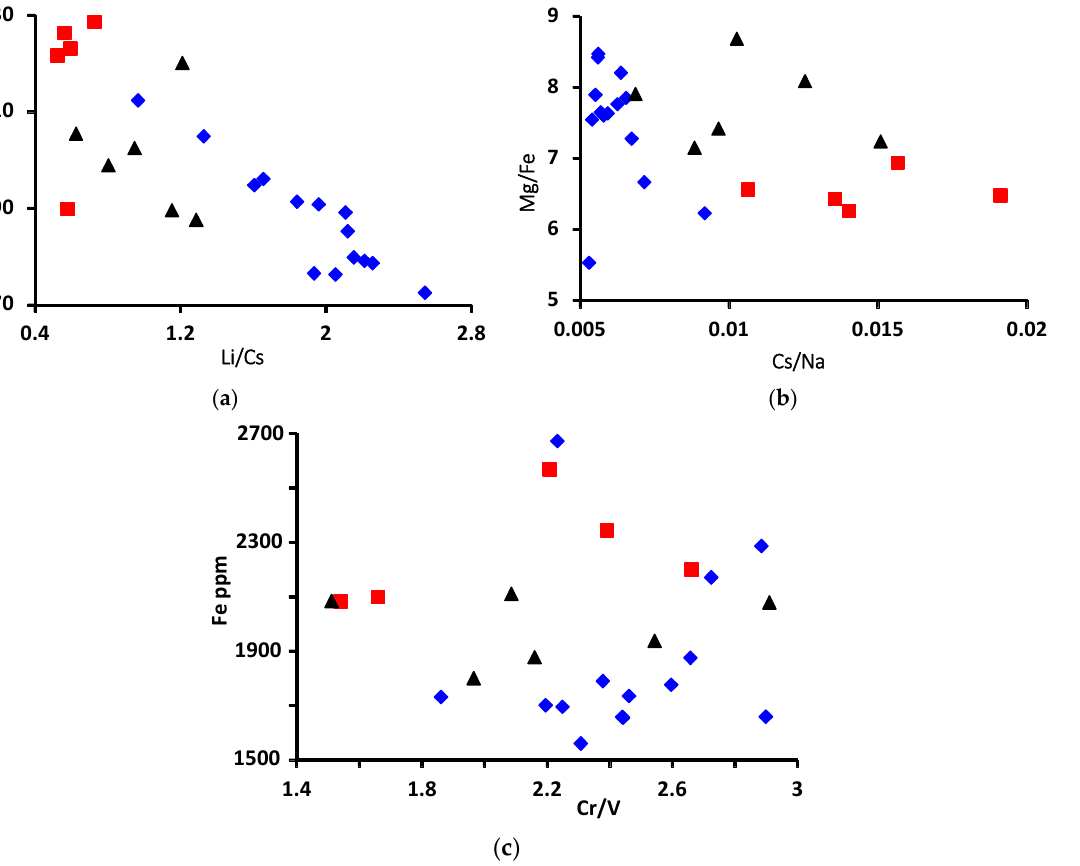
Figure 9. ( a ) Na/Li vs. Li/Cs ratios, ( b ) Mg/Fe vs. Cs/Na ratios and ( c ) Fe vs. Cr/V ratio plots in the analyzed beryl from Wadi Nugrus. Symbols are the same as in Figure 5: red square for bright-green rim (spots 1–5), black triangle for pale-green rim (spots 20–25) and blue lozenge for brown-green core (spots 6–19) of beryl crystal.